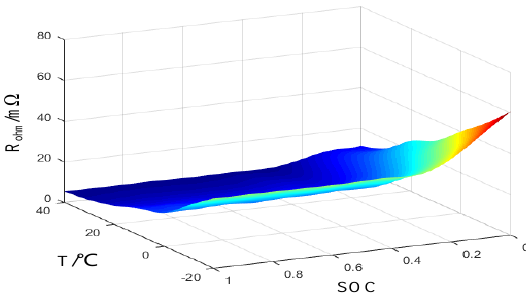
Figure 5. Relationship among fitted R ohm and SOC, T .